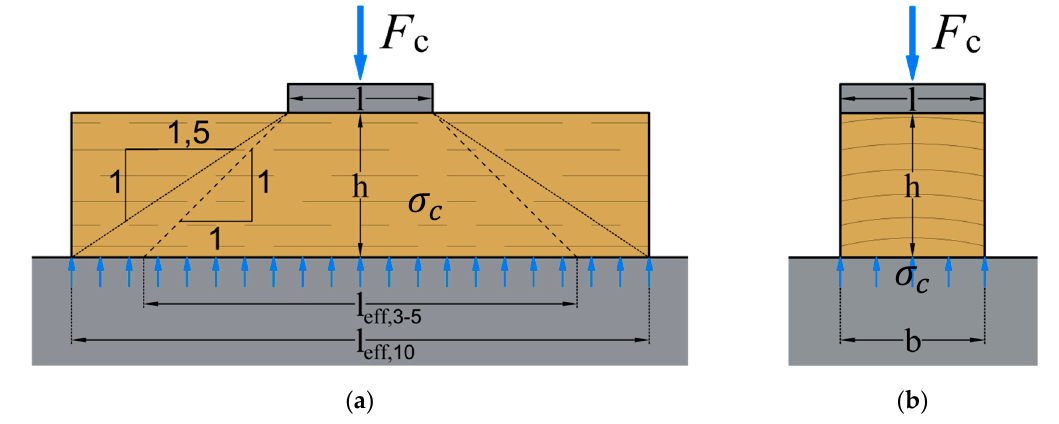
Figure 6. Theoretical compressive stress σ c perpendicular to the grain in the radial direction spreading over the e ff ective length l ef f on the lateral face ( a ), and over the width b on the transversal face ( b ), for a determined height ℎ of the timber sample. Schemes inspired from [9].